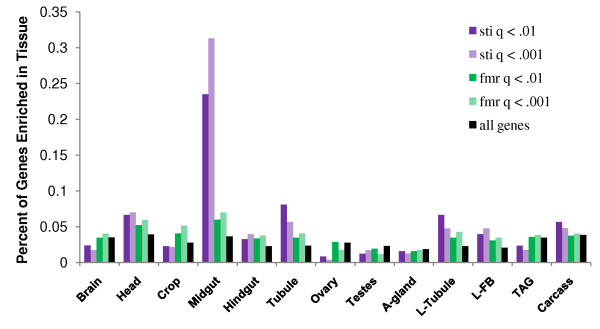
Tissue specificity of misexpressed genes. For each tissue (head, brain, crop, midgut, hindgut, Malpighian tubule, ovary, testes, accessory gland, larval Malpighian tubule, larval fat body, thoracico-abdominal ganglia, and thoracic and abdominal carcass), a list of genes enriched in that tissue was compiled based on the FlyAtlas data set (see methods). These lists were then compared to the lists of misexpressed genes in sticky and dFmr1 mutants at q<.01 and q<.001. Each column represents the percent of all misexpressed genes in a given list that were enriched in a given tissue. The black columns represent the percent of all genes in the fly genome that were defined as enriched in a particular tissue. These can be interpreted as the percentage of tissue enriched gene that would be expected in a random list of genes.